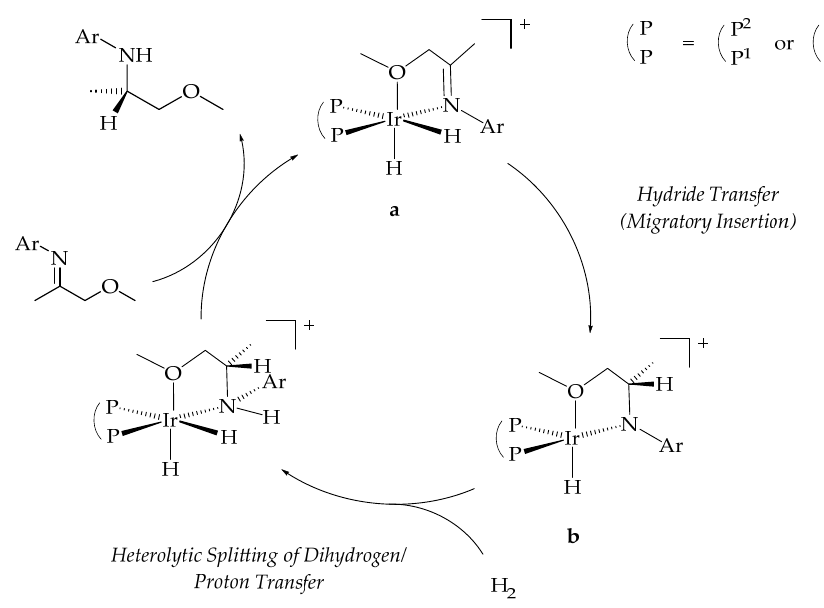
Figure 1. Inner-sphere mechanism with substrate coordination to iridium (previous works [11,12]).